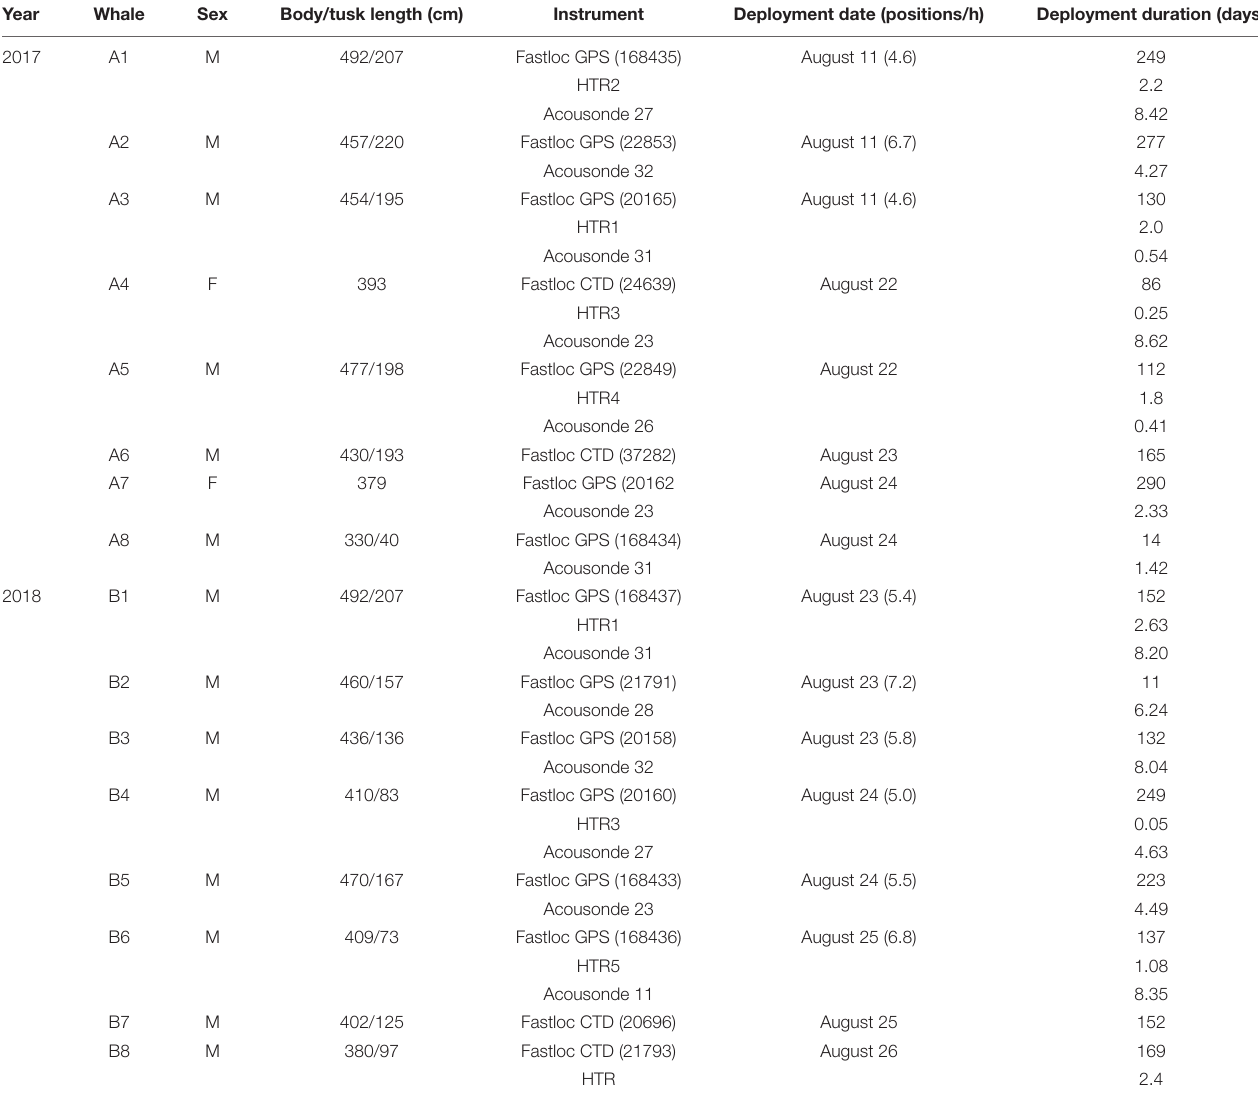
TABLE 1 | Overview of instrumentations of narwhals in August 2017 and 2018 with Fastloc GPS receiver, Fastloc CTD tag, acoustic and orientation tags (Acousonde), and heart-rate recorders (HTR). Year Whale Sex Body/tusk length (cm) Instrument Deployment date